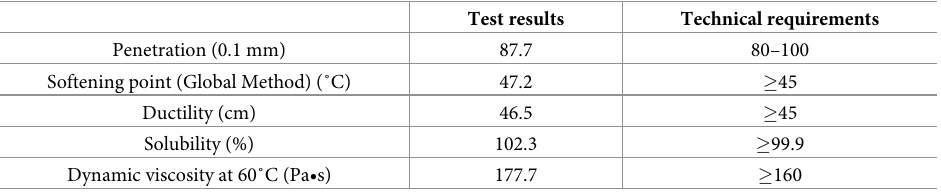
Table 1. The technical indicators of the SK-90 matrix asphalt used in this